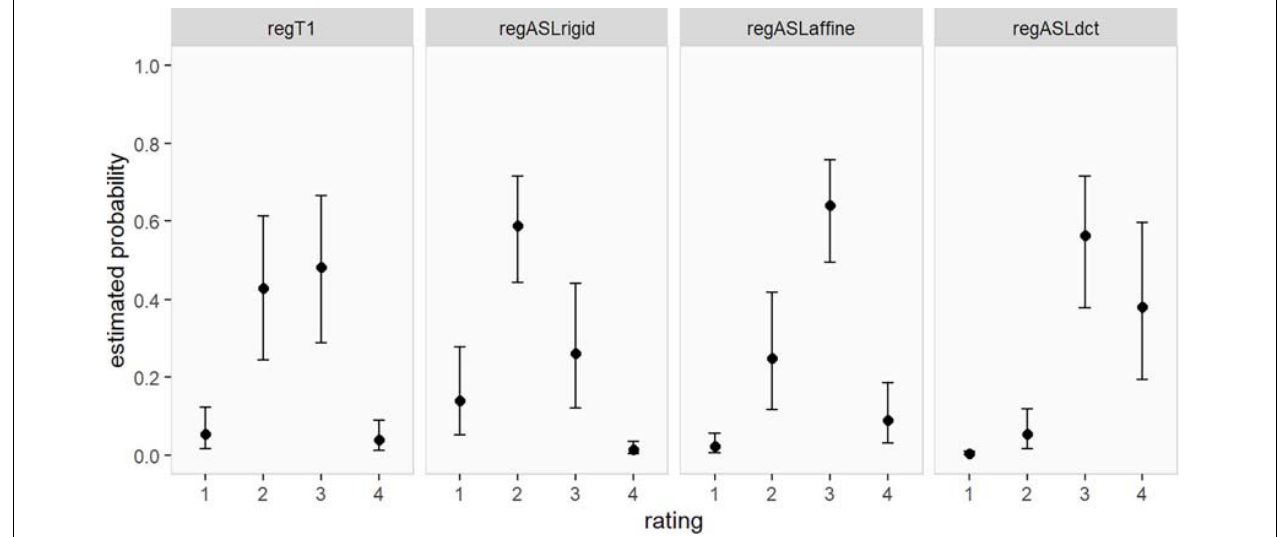
FIGURE 4 | Estimated probability (and corresponding 95% CI) of obtaining a certain rating for each type of registration (for patients).